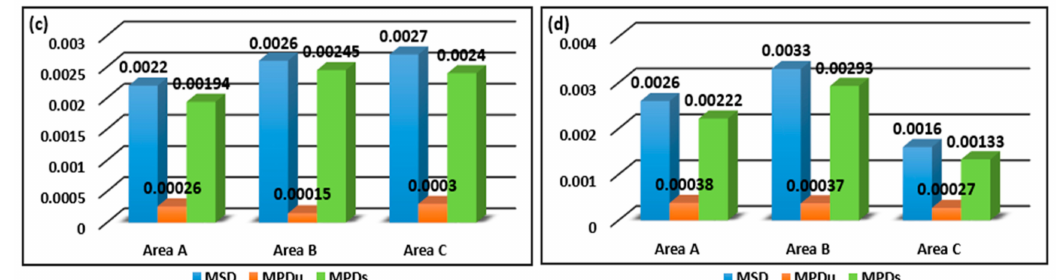
Figure 4. Agreement assessment of integration results: ( a ) exhibits the values of agreement coefficient (AC); ( b ) exhibits the ratio of unsystematic mean product-difference (MPDu) to systematic mean product-difference (MSD); ( c ) exhibits the values of systematic mean product-difference (MSD), unsystematic mean product-difference (MPDu) and systematic mean product-difference (MPDs) based on CCD and ETM+; and ( d ) exhibits the values based on CCD and OLI.